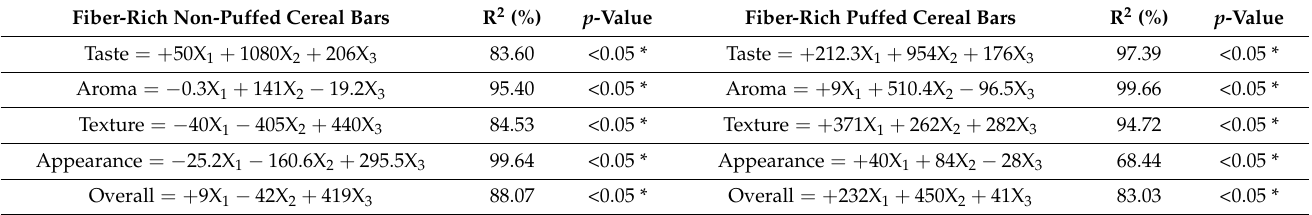
Table 3. Regression equation for the fiber-rich cereal bars responses with predicted R-square